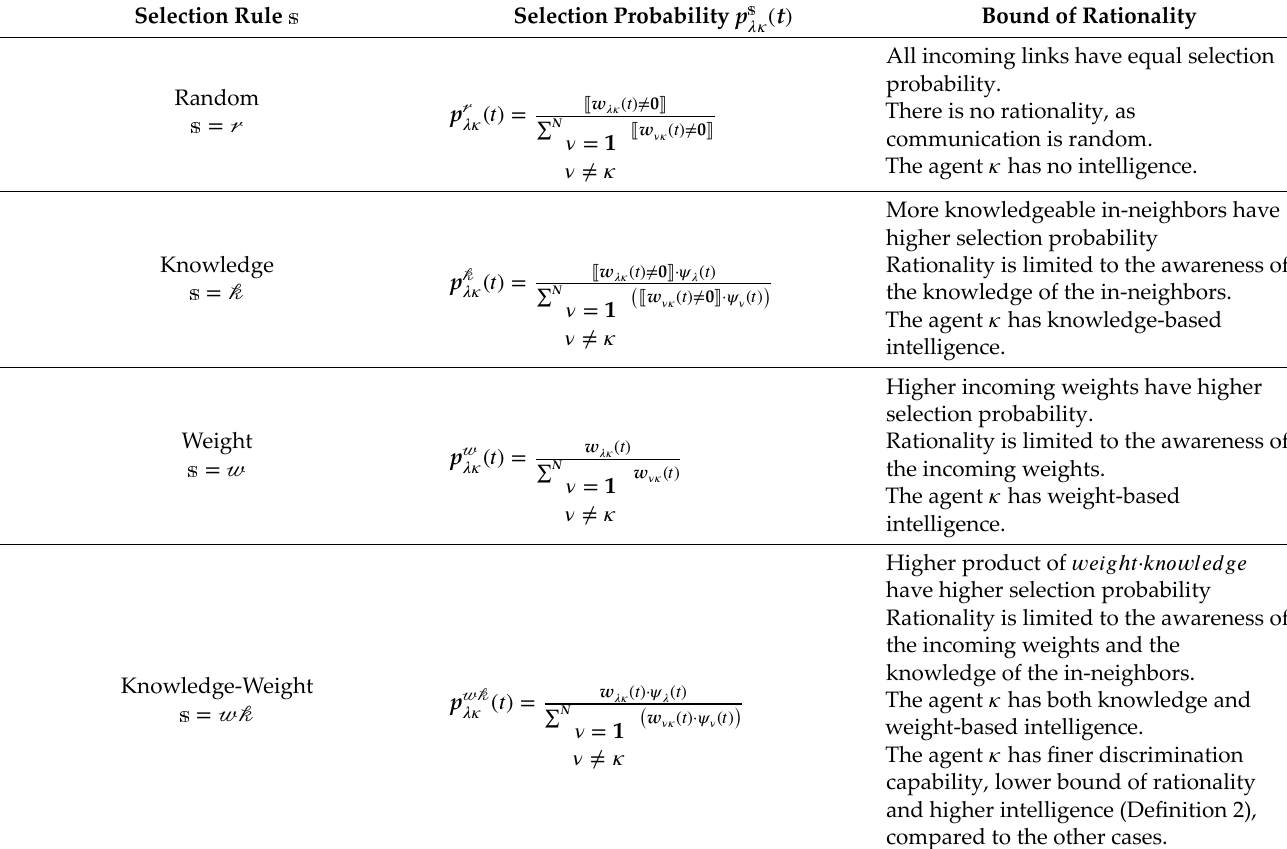
Table 1. Probabilistic selection rules for knowledge